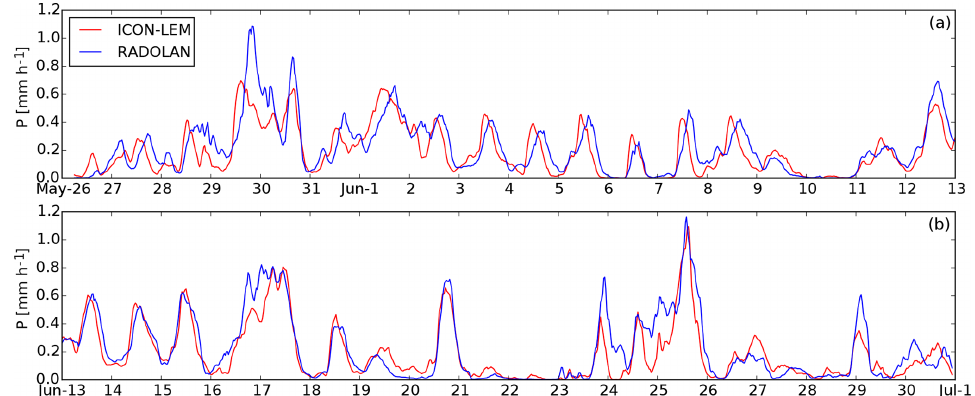
Figure 7. Time series of the mean precipitation intensity P for the 625m grid spacing ICON-LEM simulation, and the RADOLAN-derived precipitation intensity, for the full 36d period from 26 May until 30 June 2016. Note that the time series was broken into the upper and the lower panels. Averaging was carried out over all grid boxes where radar data are